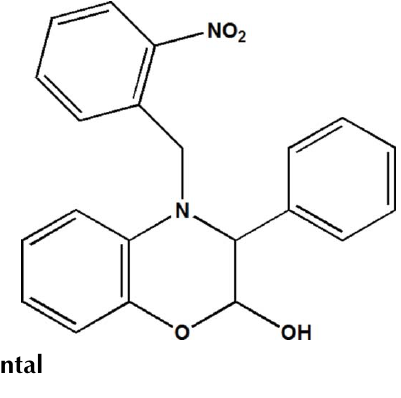
Data collection Bruker APEXII CCD area-detector diffractometer Absorption correction: multi-scan ( SADABS ; Sheldrick, 2002) T min = 0.860, T max = 1.000